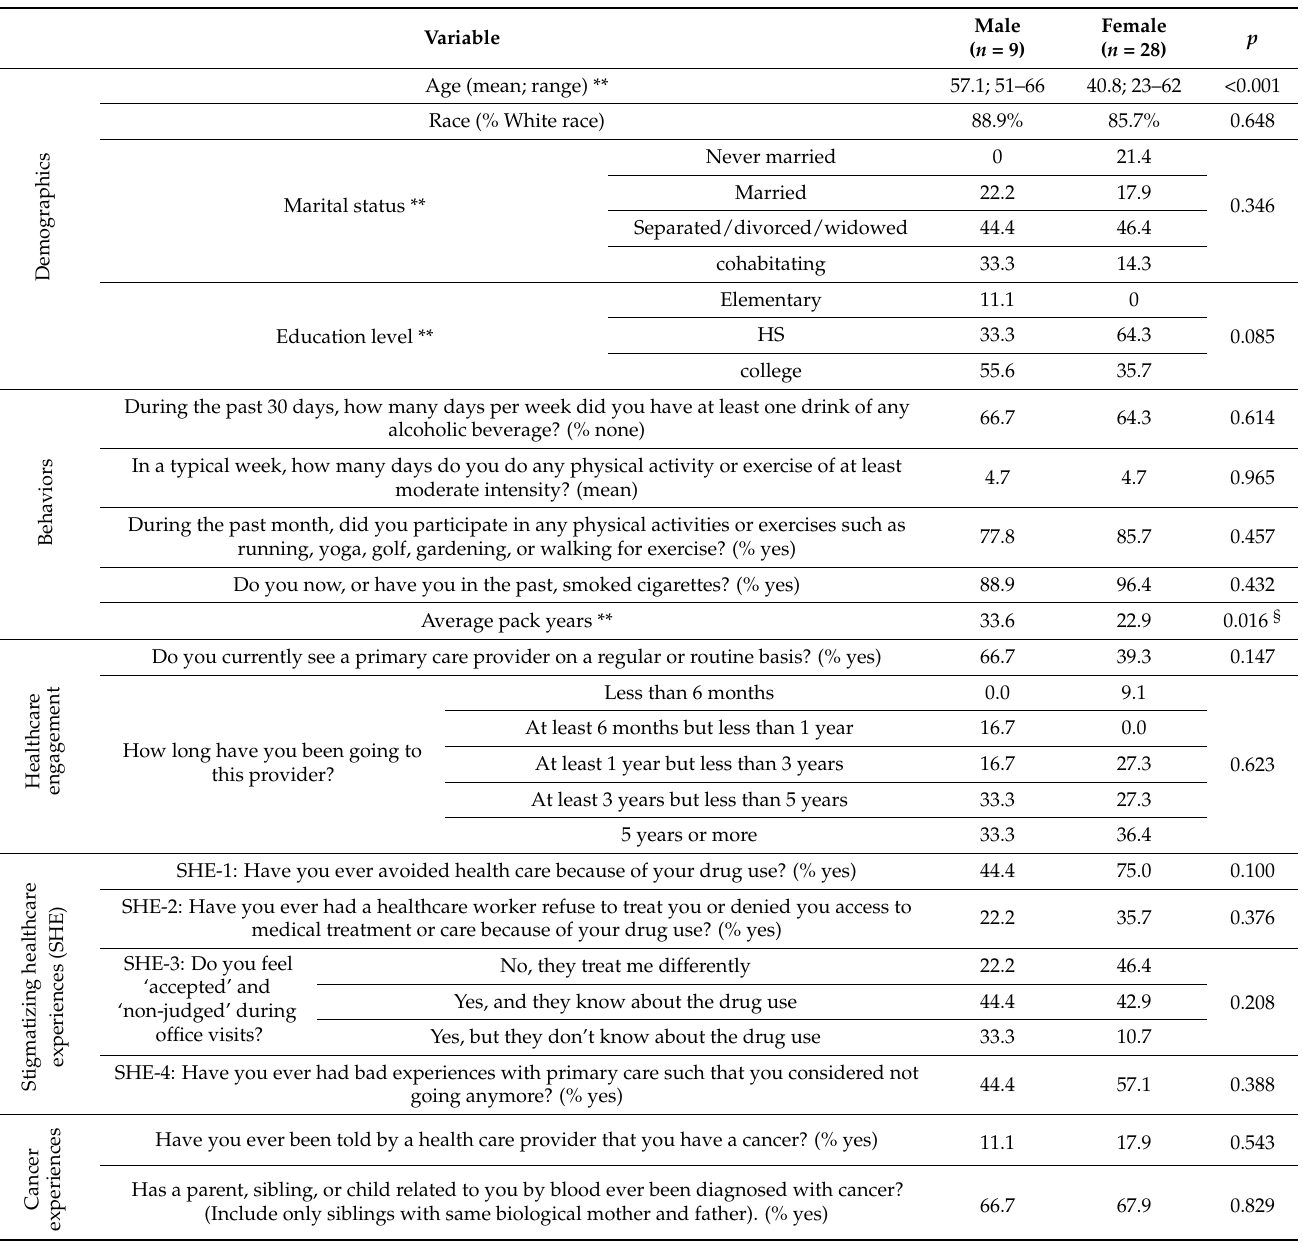
Table 1. Participant demographics, alcohol and tobacco use, and experiences with healthcare and cancer ( n =